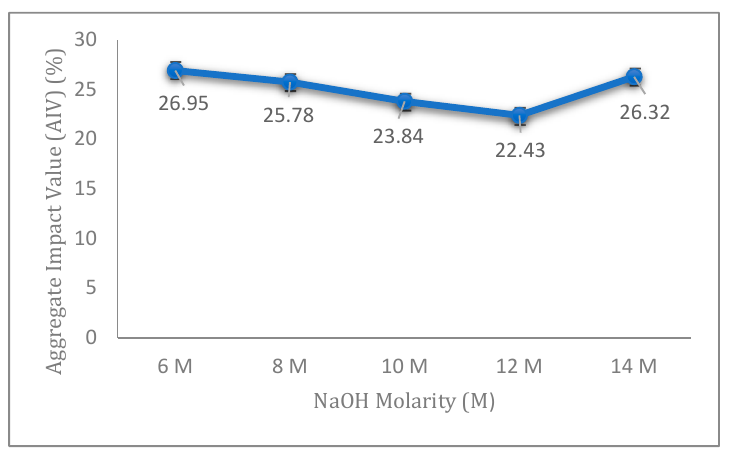
Figure 1. Aggregate impact value (AIV) of the fly ash geopolymer aggregate at various of NaOH molarities.